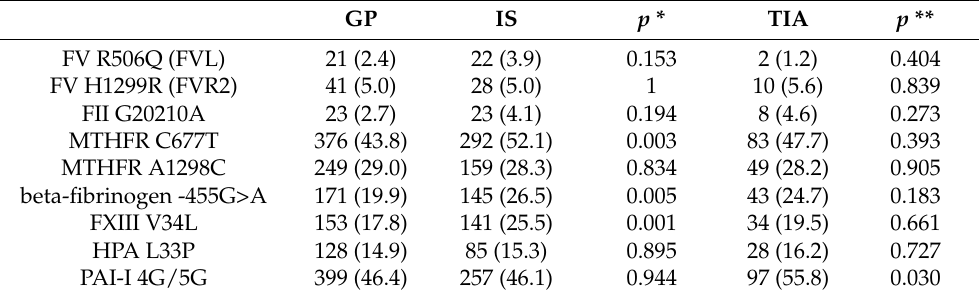
Table 2. Allele frequency, n and (%) of the nine gene variants. Comparison between ischemic stroke (IS, n = 282) or transient ischemic attack (TIA, n = 87) versus the general population (GP, n = 430).